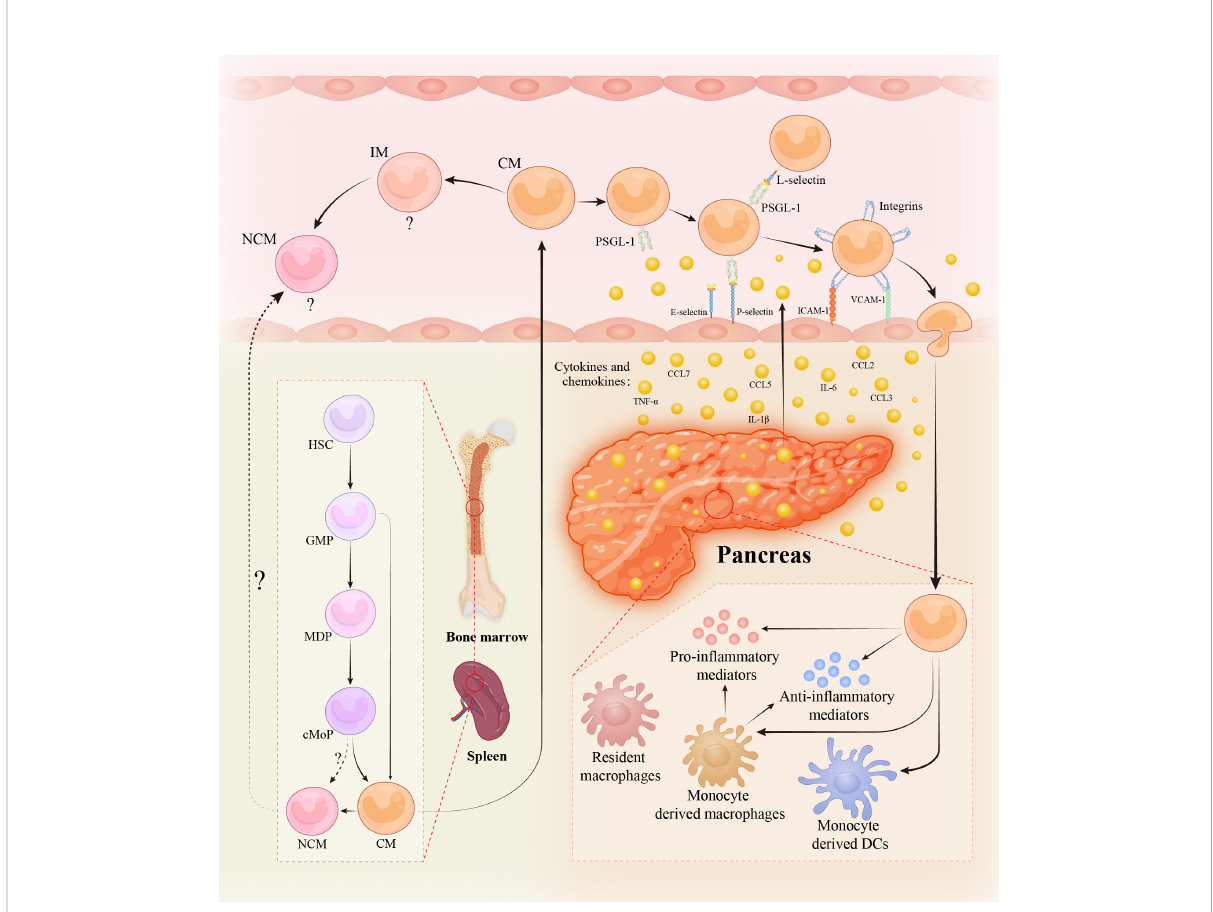
FIGURE 1 Monocytes in acute pancreatitis. Monocytes are continuously produced in bone marrow (BM) and spleen from hematopoietic stem cells (HSCs) via granulocyte and macrophage progenitors (GMPs), monocyte/dendritic cell (DC) progenitors (MDPs), and common monocyte progenitors (cMoPs) intermediates. During acute and severe in fl ammation, monocytes might be directly generated from GMPs in response to the need for rapid generation. Non-classical monocytes (NCMs) are derived from classical monocytes (CMs) and might be directly developed from cMoPs. The existence of NCMs in BM/spleen and the regulatory mechanisms of their egress into circulation are disputable and obscure. Intermediate monocytes (IMs) are the transitional cells of CMs and NCMs with distinct functions. The role of NCMs and IMs in acute pancreatitis (AP) is still vague. During AP, pancreatic acinar and ductal cells are injured and liberate damage-associated molecular patterns, cytokines, chemokines, and various pro-in fl ammatory mediators, leading to the recruitment of circulating monocytes to the in fl amed pancreas. Monocytes migration across the endothelium requires a series of sequential adhesive interactions between monocytes and endothelial cells mediated by the indicated endothelial adhesion molecules and monocyte selectin and integrin ligands. When monocytes in fl ux into the pancreas, they either develop into monocyte-derived macrophages/DCs or maintain monocyte-state. The in fi ltrated monocytes and monocyte-derived macrophages exhibit heterogeneous phenotypes such as pro-in fl ammatory or anti-in fl ammatory activities, depending on the environmental cues.